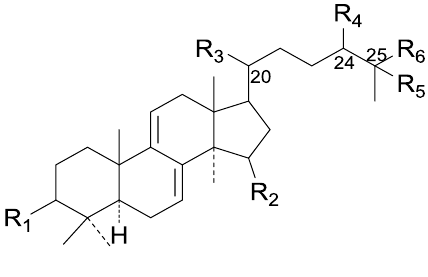
Figure 20. Structures of compounds 197 – 213